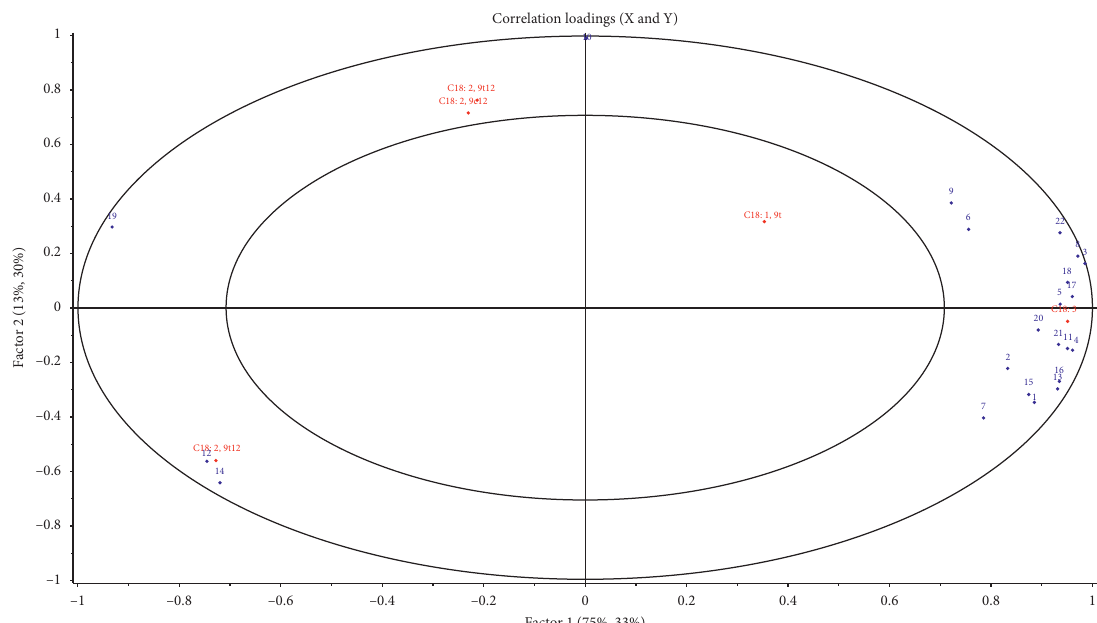
Figure 1: Analysis of the correlation between the content of trans fatty acids and the key volatile flavour substances in youtiao fried in 5 different vegetable oils. Note: the flavour substances represented by the figures are (1) hexanal; (2) heptyl aldehyde; (3) caprylic aldehyde; (4) furfuryl mercaptan; (5) 3-methylbutyraldehyde; (6) trans-2-nonenal; (7) phenylacetaldehyde; (8) trans,cis-2,6-nonadienal; (9) trans-2- decenal; (10) trans, trans-2,4-sebacedienal; (11) 1-octene-3-alcohol; (12) trans-2-hexenal; (13) 3-hydroxy-2-butanone; (14) vanillin; (15) 2,3- dimethylpyrazine; (16) 2-ethyl-3,5-dimethyl-pyrazine; (17) furfuryl alcohol; (18) 2,5-dimethyl-4-hydroxy-3 (2H)-furanone; (19) 3-ethyl-2,5- dimethylpyrazine; (20) 3-(methyl sulphide) propionic aldehyde; (21) undecanoic